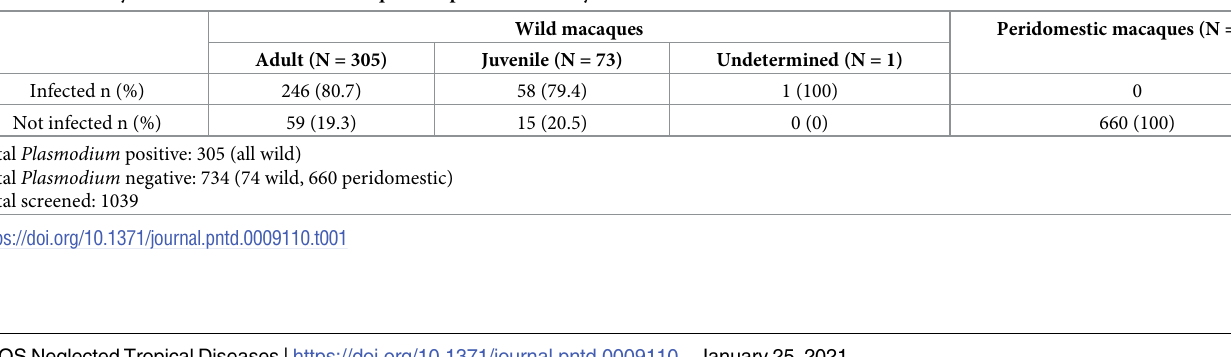
Table 1. Summary of malaria infections in macaques sampled in this